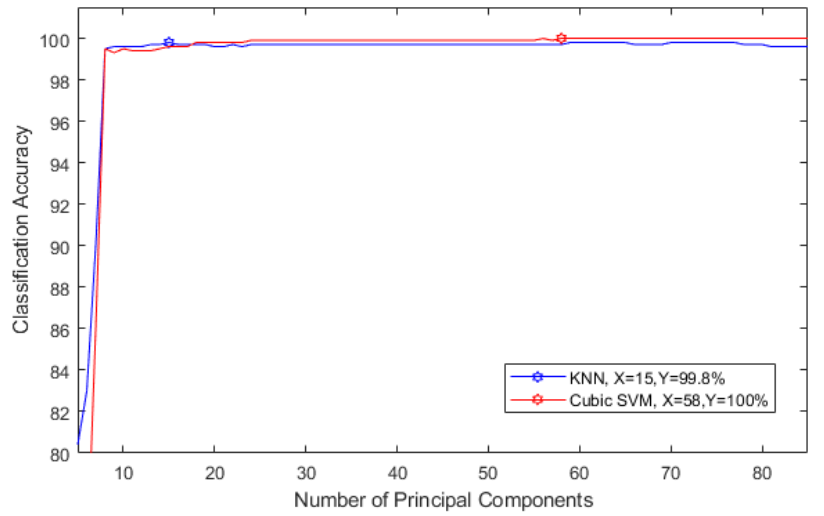
Figure 12. Selecting the optimal number of principle components for detecting stress .